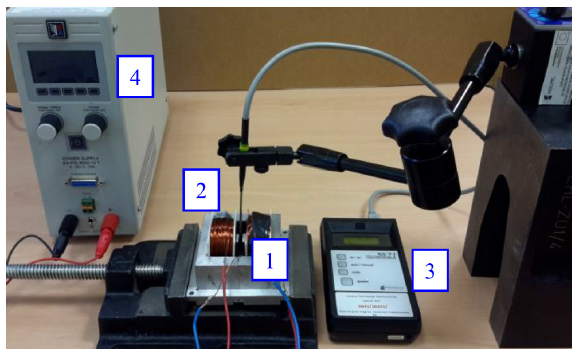
Figure 6. Test stand: 1—examined magnetic circuit, 2—probe, 3—teslameter, 4—DC power supply.